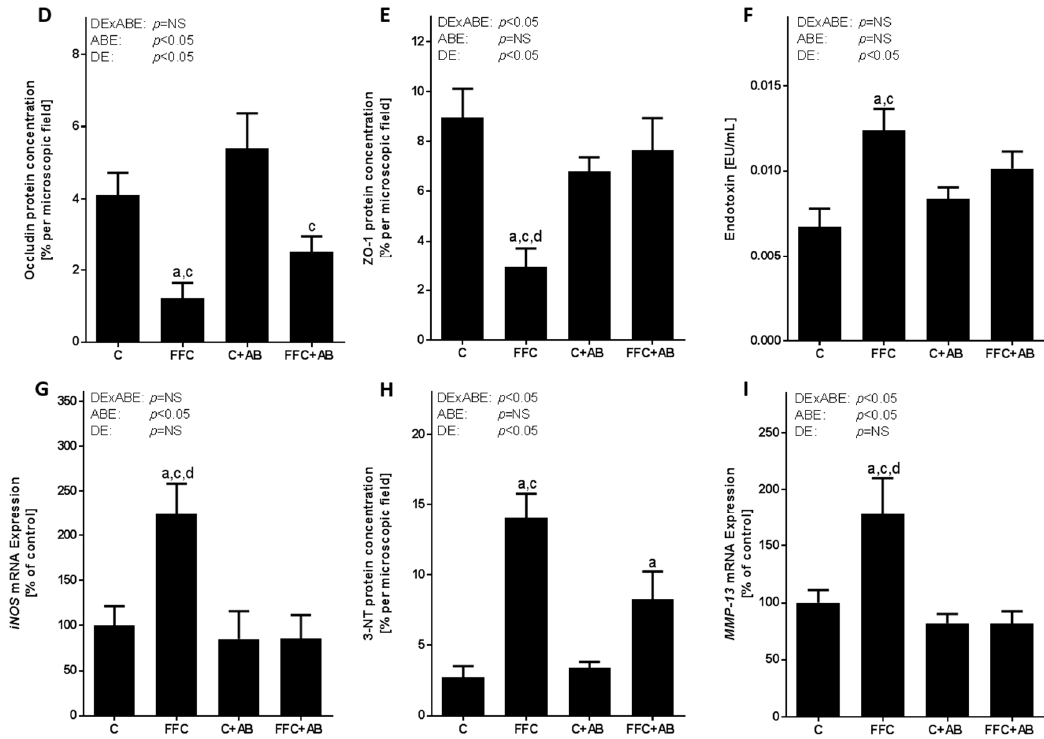
Figure 4. Effect of the short-term feeding of a FFC or control diet ± oral antibiotic treatment on markers of intestinal barrier function and iNOS mRNA expression as well as 3-NT protein adducts and MMP-13 mRNA expression in small intestine. Representative pictures of ( A ) occludin; ( B ) ZO-1 and ( C ) 3-NT staining (400 × ) in small intestine and densitometric analysis of ( D ) occludin and ( E ) ZO-1 protein staining in small intestine and ( F ) endotoxin concentration in plasma of portal vein; ( G ) iNOS mRNA expression; ( H ) densitometric analysis of 3-NT protein adduct staining and ( I ) MMP-13 mRNA expression in small intestine. 3-NT: 3-nitrotyrosine; ABE: antibiotic effect; C: control diet; C + AB: control diet and oral treatment with antibiotics; DE: diet effect; DE × ABE: interaction between diet and antibiotics; FFC: fat-, fructose- and cholesterol-rich diet; FFC + AB: fat-, fructose- and cholesterol-rich diet and oral treatment with antibiotics; iNOS: inducible nitric oxide-synthase; MMP-13: matrix metalloproteinase-13; NS: not significant; ZO-1: zonula occludens-1. a p < 0.05 compared with mice fed a control diet; c p < 0.05 compared with mice fed a control diet treated with antibiotics; d p < 0.05 compared with mice fed a FFC diet treated with antibiotics.